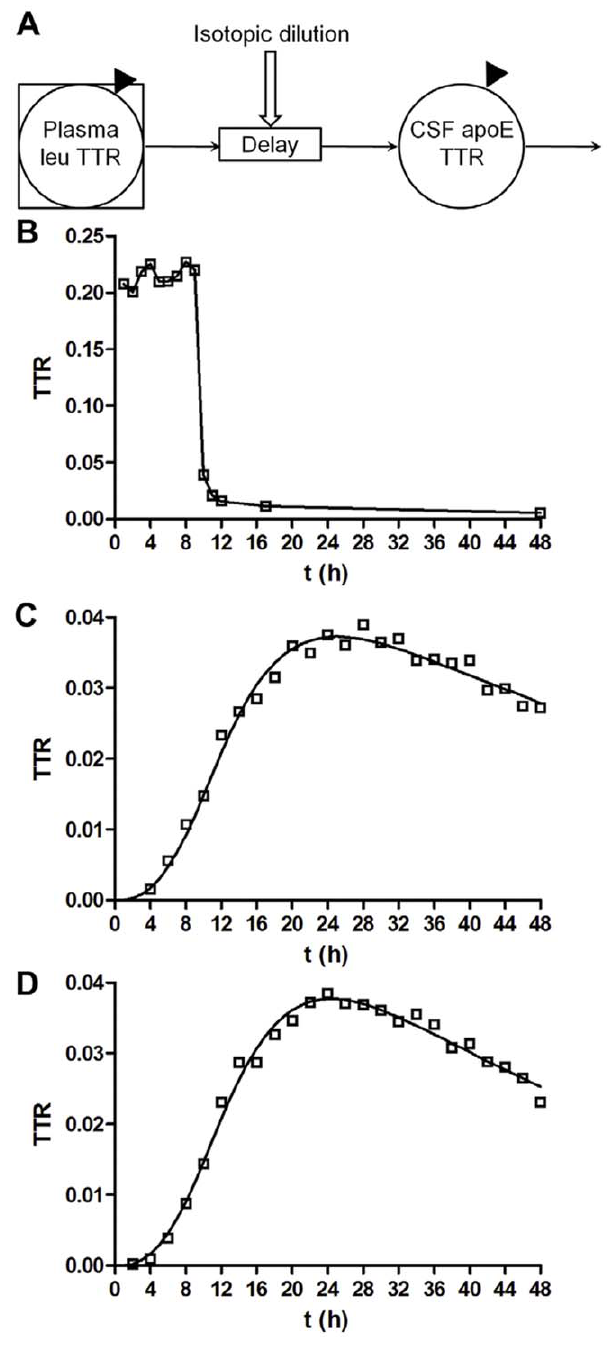
Figure 4. CNS kinetic modeling curves. A , CNS-ApoE compart- mental model was used to describe whole-system CNS-ApoE turnover kinetics. The model is based on data from plasma leucine and CSF-ApoE TTRs (solid triangles). The plasma leucine TTR time course for a given subject is used as a ‘‘forcing function’’ to define the tracer availability for ApoE synthesis. The CNS-ApoE system comprises a delay element and a compartment that turns over, and accounts for isotopic dilution of the plasma leucine. The model has 3 adjustable parameters: the shape of the ApoE TTR time course is modified by adjusting the delay time and the rate constant for ApoE turnover, and the magnitude of the ApoE TTR is scaled by varying the degree of isotopic dilution. B–D , A typical compartmental model analysis from a single, representative, ApoE3/3 subject. B , Plasma leucine TTR remains elevated and does not return to baseline enrichment immediately after the tracer infusion is halted.